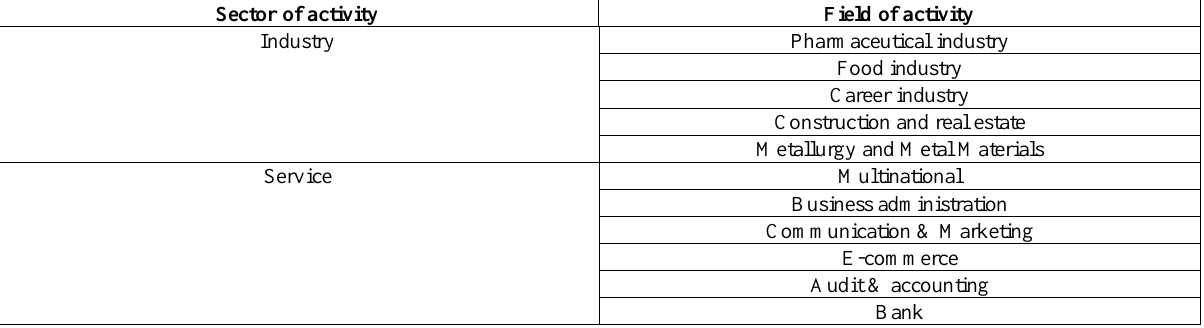
Table 2. The Fields of Activity of the Companies Interviewed for This